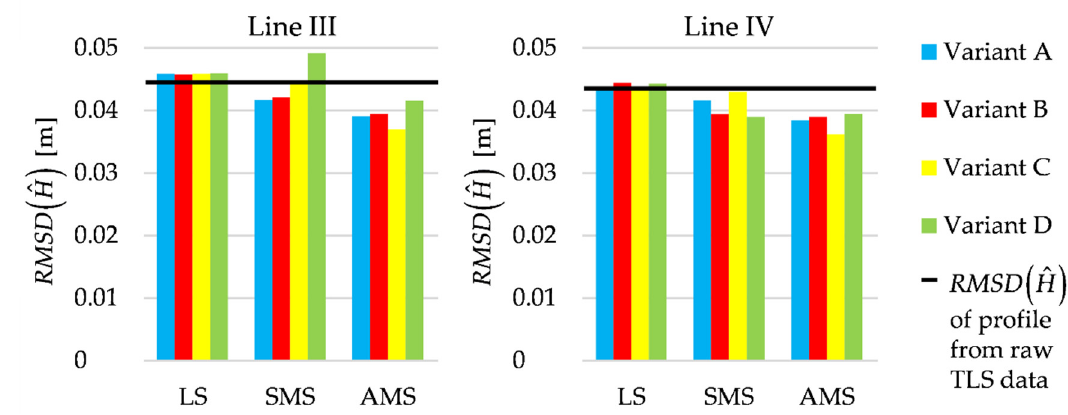
Figure 14. Lines III and IV; accuracy of the estimated profiles compared to accuracy of the profile obtained from raw TLS data.